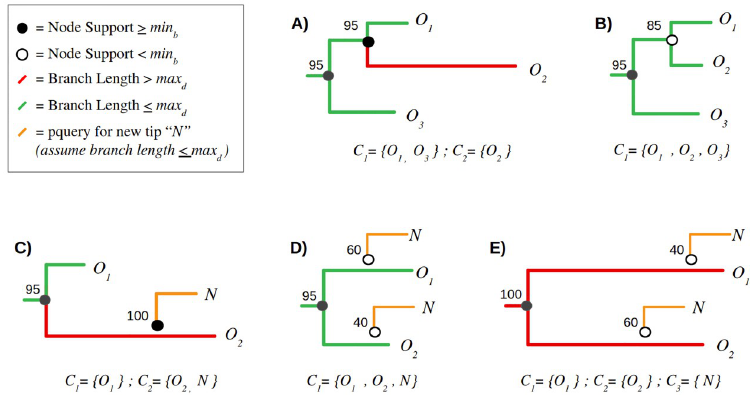
Fig 1. Examples of clustering definition and growth criteria. Subtree (A) represents a paraphyletic cluster ( C 1 ) of two background (old) sequences, O 1 and O 3 , excluding a third sequence O 2 that is too distance from the root node of C 1 . Consequently, O 2 becomes its own cluster of one, C 2 . Subtree (B) illustrates a monophyletic cluster where all background sequences meet this criterion. Subtrees (C-E) depict the addition of a new (incident) sequence N to an existing cluster. In (C), the new sequence is added with 100% confidence to a cluster of one background sequence, O 2 . Conversely, the placement of N in subtrees (D) and (E) is highly uncertain (with bootstrap supports 40% and 60%). For (D), N becomes incorporated into the same cluster irrespective of its placement, so the bootstrap values are irrelevant. In contrast, neither placement of N in subtree (E) meets the clustering criteria due to the resulting branch lengths—as a result, N becomes a new cluster of one, C 3